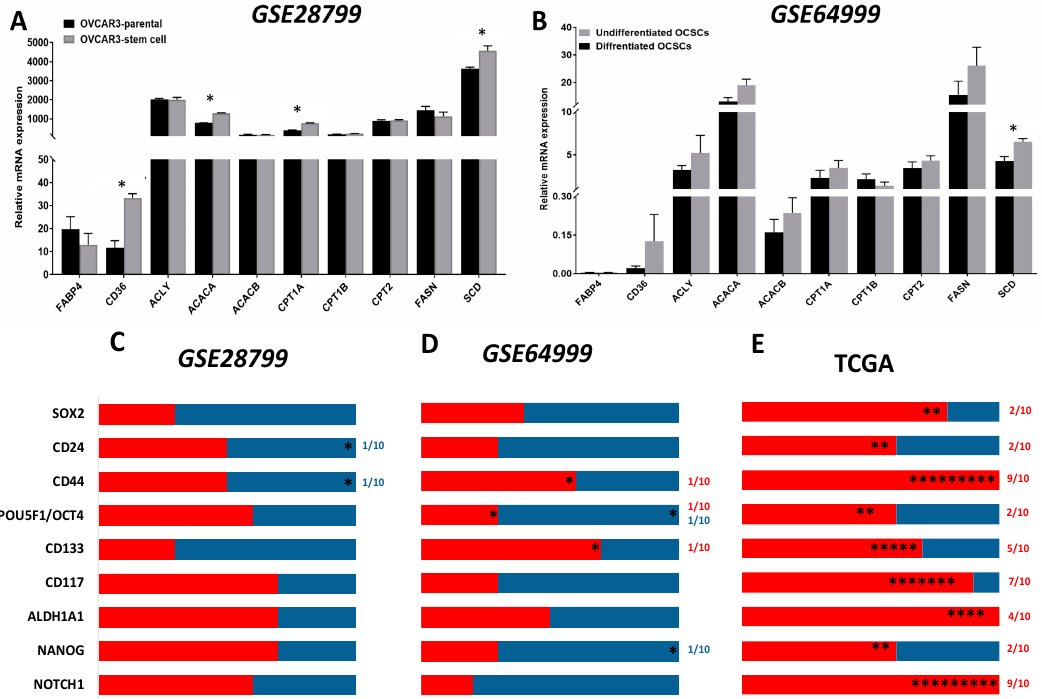
Figure 7. Expression of transporters and enzymes of lipid metabolism in OCSC models. ( A , B ) Bars represent mean ± SEM of the relative mRNA expression of the indicated transporters and lipid metabolism enzymes in OVCAR3 stem-cells vs. their parental cells in GSE28799 and undifferentiated vs. differentiated OCSCs in GSE64999. Significance was determined using the multiple t -test and Holm–Sidak method with each row analyzed individually with p < 0.05, without assuming a consistent SD. ( C – E ) Bar graphs represent the prevalence of positive ( red ) and negative ( blue ) correlations of the indicated OCSC markers and lipid metabolism enzymes in Supplement Tables S7–S8 and Table 4. * indicate the number of significant correlations either positive or negative.